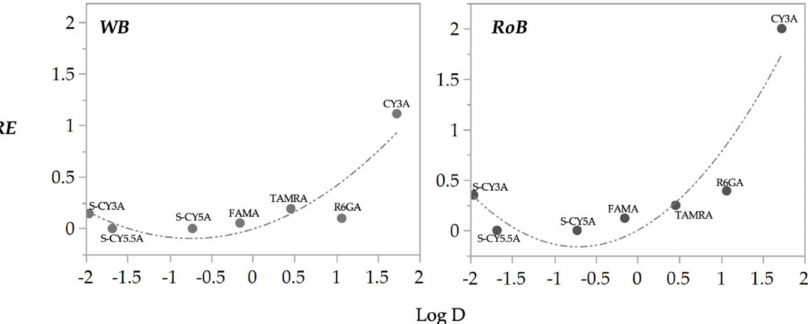
Figure 4. Relationship between observed RE and Log D for the WB ( left ) and the RoB ( right ) of the 7 fluorescent compounds. The dashed line is line of fit. Table 3. QSPkR analysis results. MLR of the RE and molecular descriptors as explanatory variable of the models. Only statistically significant models are shown. adj: R 2 adjusted. RMSE: root mean square error. p -Value (<0.05). PK.